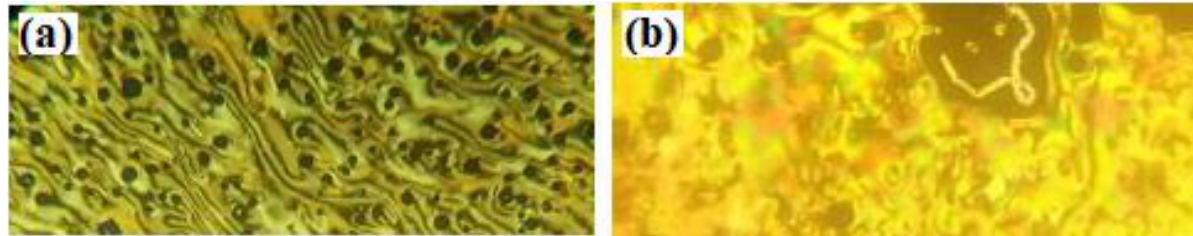
Figure 3. Textures observed upon heating under POM of nematic mesophase for ( a ) compound I6 at 141.0 °C and ( b ) compound I16 at 116.0 °C. Table 1. Mesophase transition temperatures (°C), enthalpy ΔH , kJ/mole, and normalized entropy of transition ΔS / R for compounds I n . Comp.